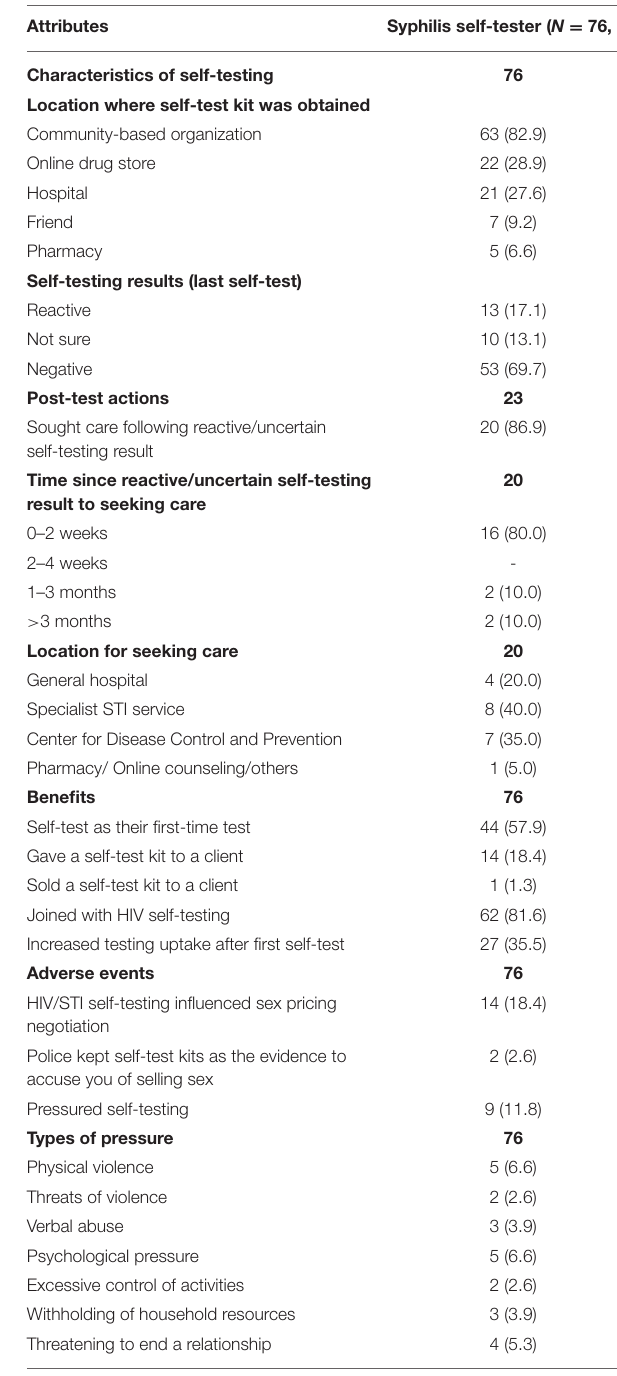
TABLE 2 | Sexual behavior characteristics among female sex workers, a cross-sectional survey in China, 2019.